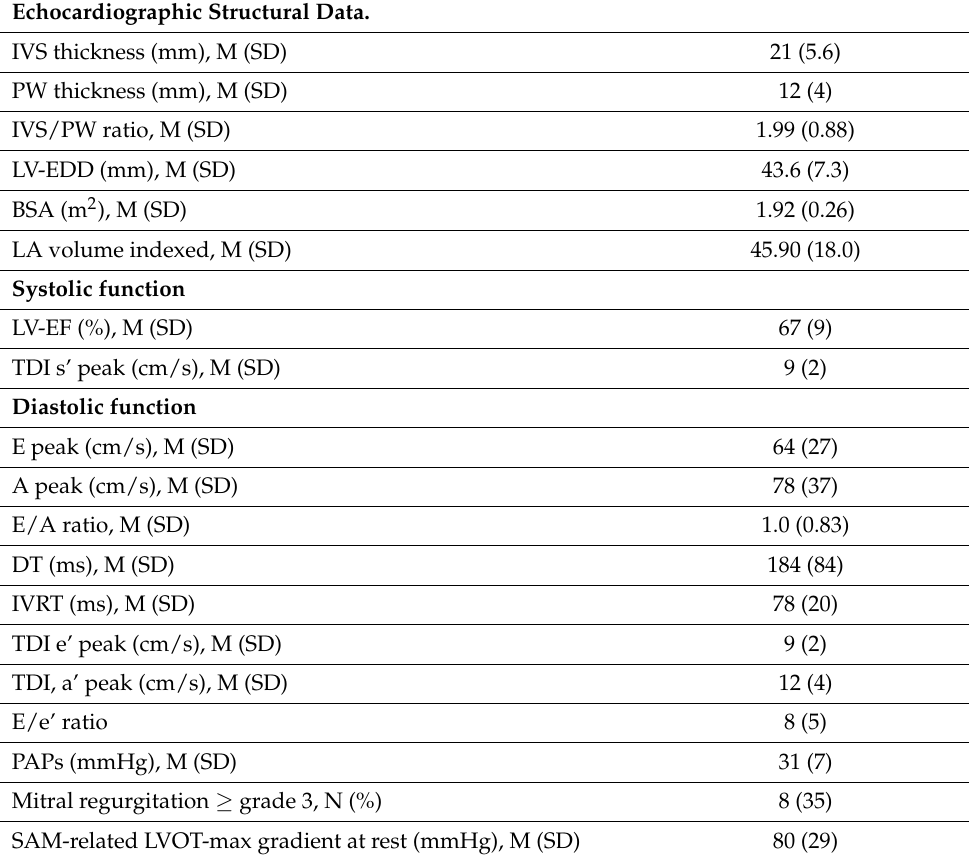
Table 2. Echocardiographic data of HCM patients. Echocardiographic Structural